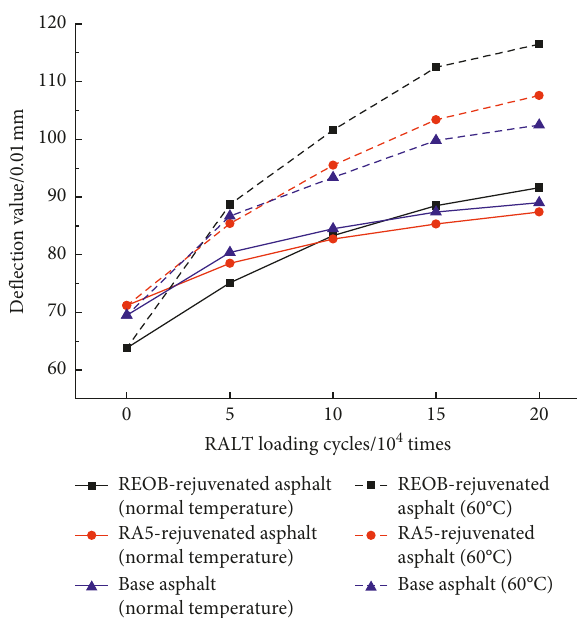
Figure 9: Relation between pavement deflection value and RALT loading cycles.